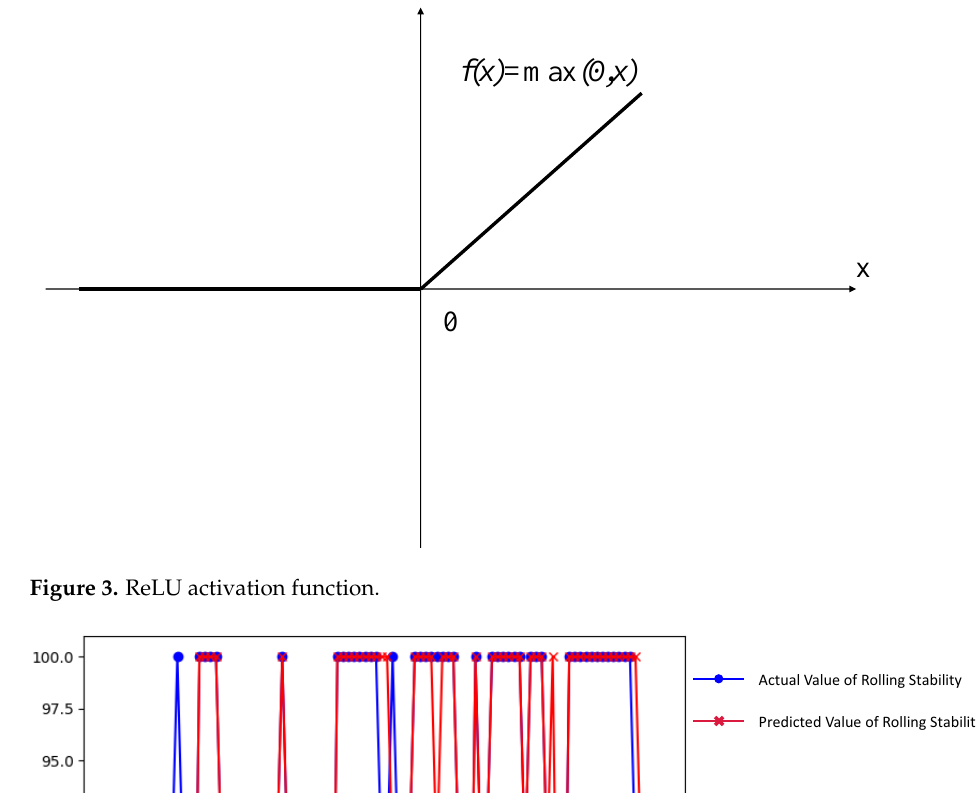
Figure 3. ReLU activation function.